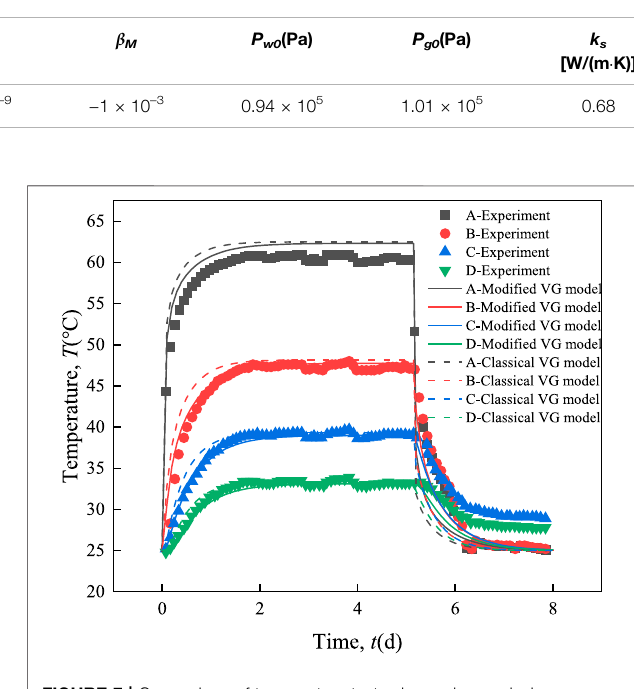
FIGURE 6 | Comparison of volumetric moisture content increment test value and numerical solution.